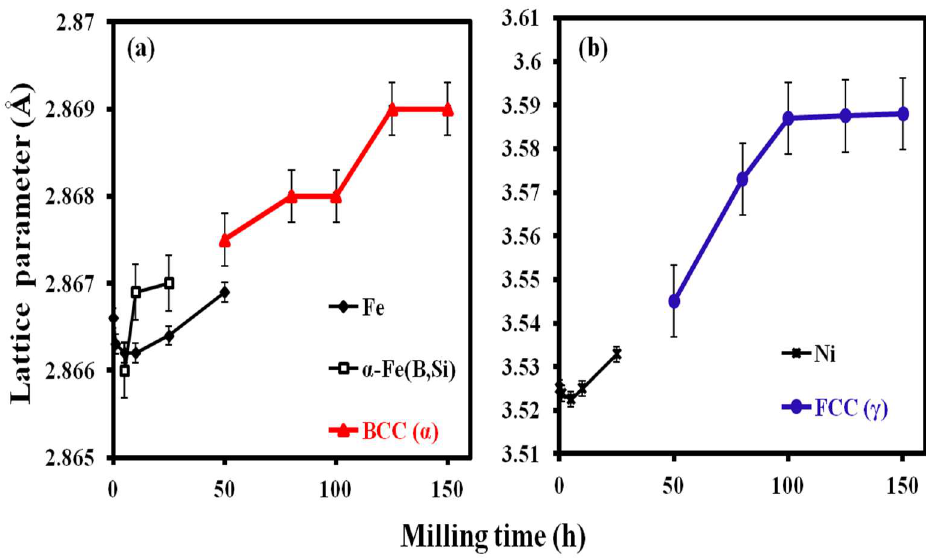
Figure 5. Lattice parameter evolution as a function of the milling time. ( a ) Fe and Fe rich phases, ( b ) Ni and Ni rich phase.